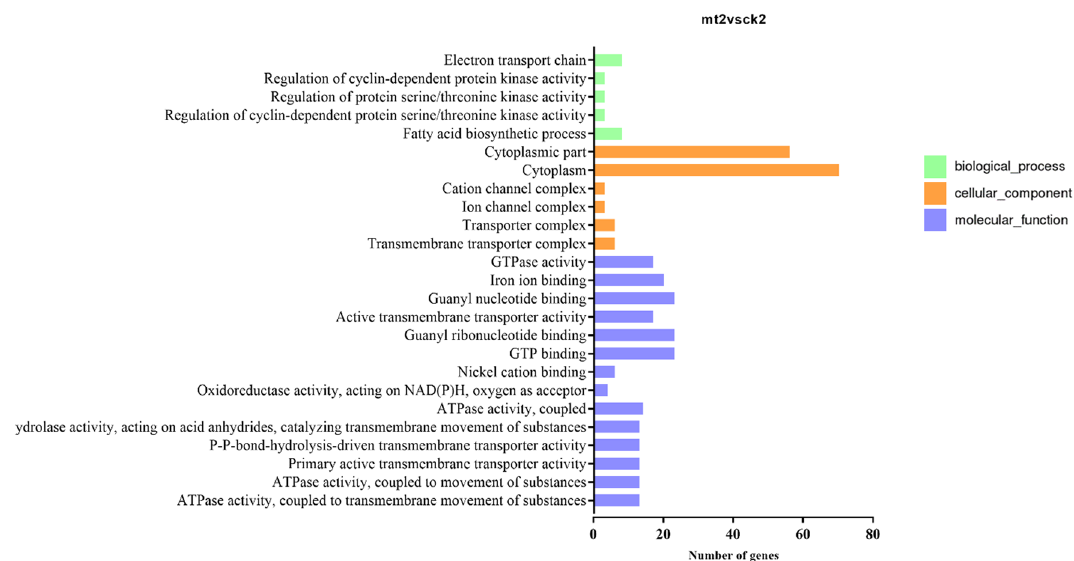
Figure 5. The most abundant gene ontologies including molecular functions, biological processes and cellular components in CK2 vs. MT2. “Cytoplasm (GO:0005737)” was the most abundant GO group, followed by “cytoplasmic part (GO:0044444)”, “GTP binding (GO:0005525)”, “guanyl ribonucleotide binding (GO:0032561)”, “guanyl nucleotide binding (GO:0019001)” and “iron ion binding